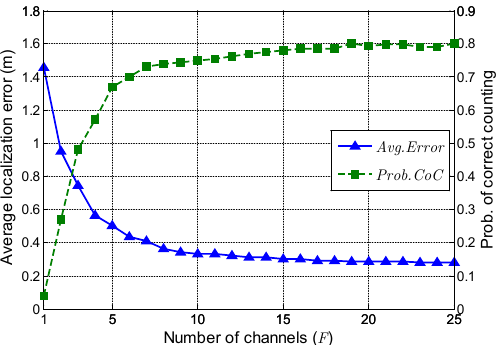
Figure 7. The performance of ComDec when channel number varies from 1 to